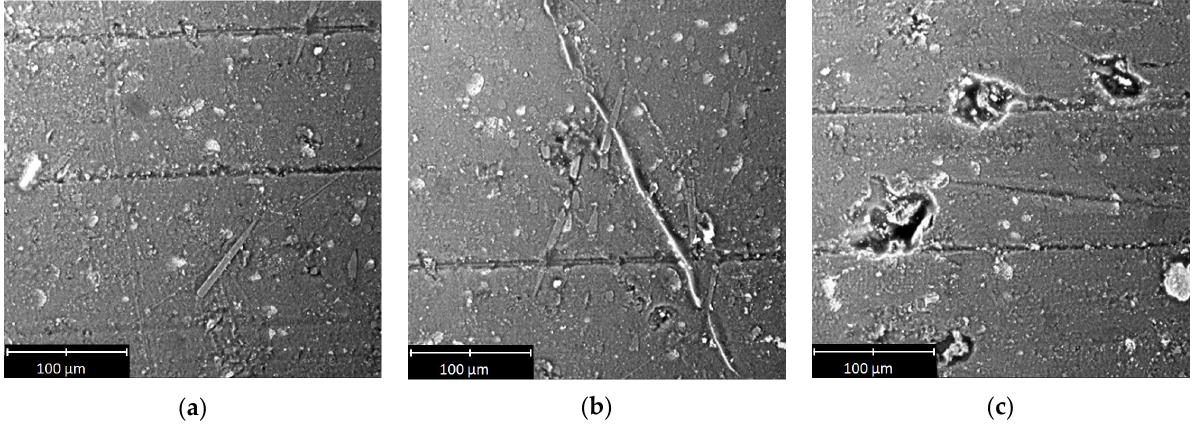
Figure 9. Selected SEM micrographs of sliding surface of PEEK/BG.